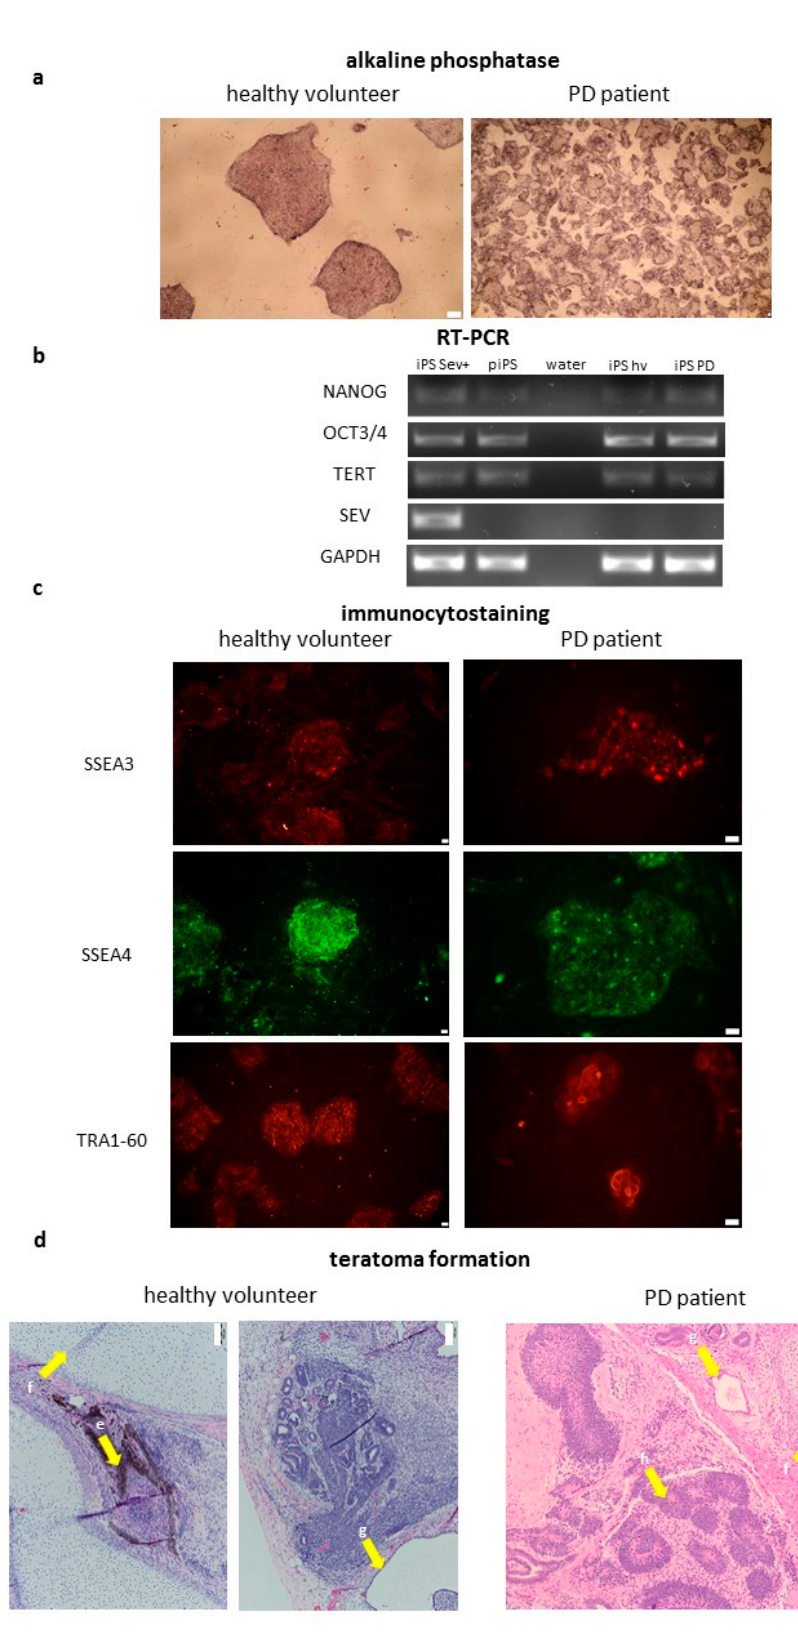
Figure 2. Characterization of PMBCs-derived iPSCs lines from two healthy volunteers